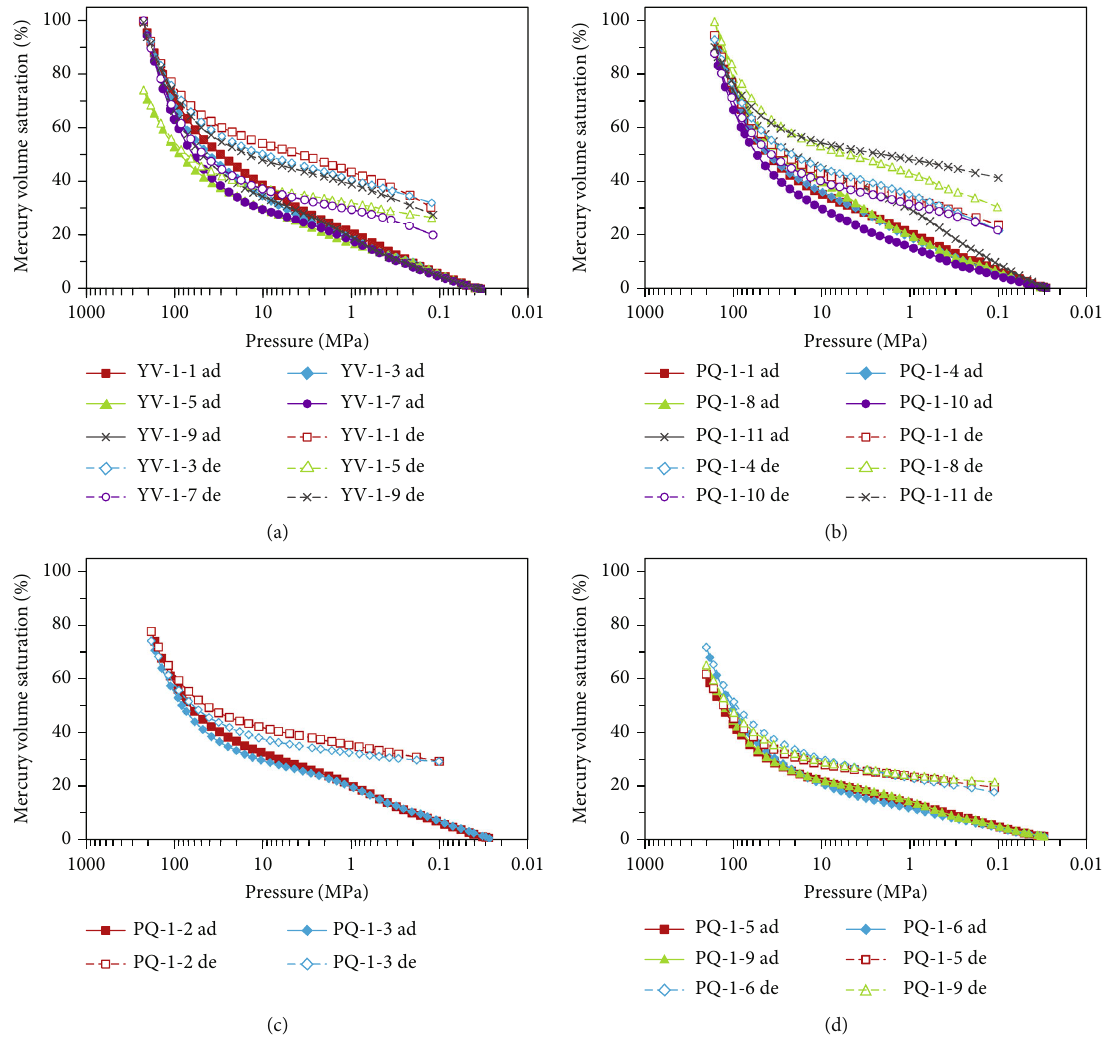
Figure 7: Mercury injection (ad) and withdrawal curves (de) of di ff erent coal facies. (a) Moist forest peat swamp facies of YV-1 well; (b) moist forest peat swamp facies of PQ-1 well; (c) shallow-water covered forest peat swamp facies of PQ-1 well; and (d) dry forest peat swamp facies of PQ-1